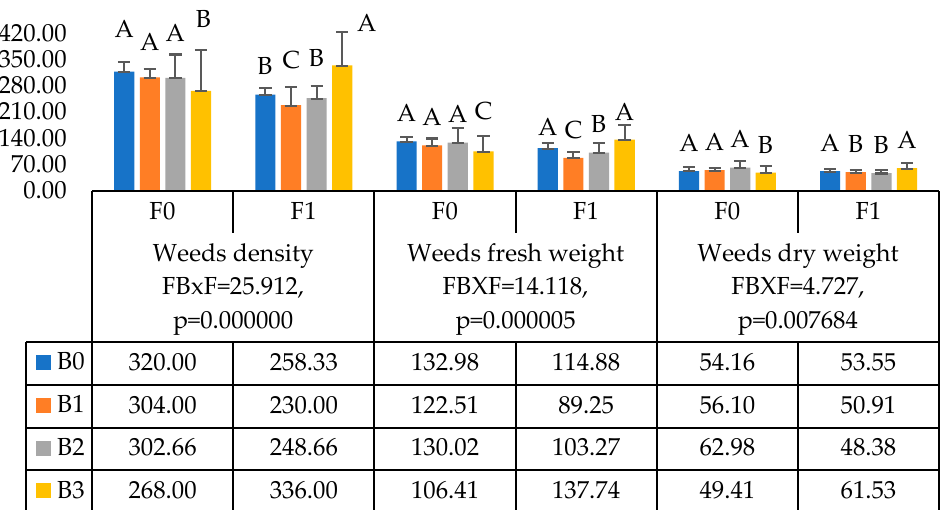
Figure 6. The influence of biochar (B0-0 t ha − 1 , B1-5 t ha − 1 , B2-10 t ha − 1 , B3-15 t ha − 1 ) and fertilization (F0—without fertilization, F1—optimal fertilization) interactions on weed incidence. FBXF—F-test for biochar–fertilization interaction, p–p value. Columns marked with different capital letters are statistically different using the protected least significant difference (LSD) test at p < 0.05.